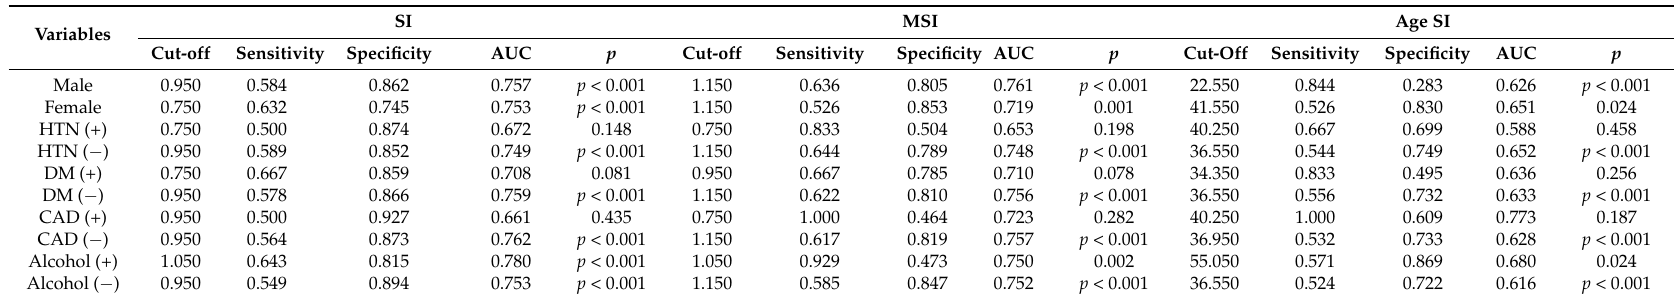
Table 4. Cut-off value, sensitivity, and specificity of SI, MSI, and Age SI in predicting MT according to stratification of the groups of patients by the sex, absence or present of HTN, DM, CAD, and alcohol